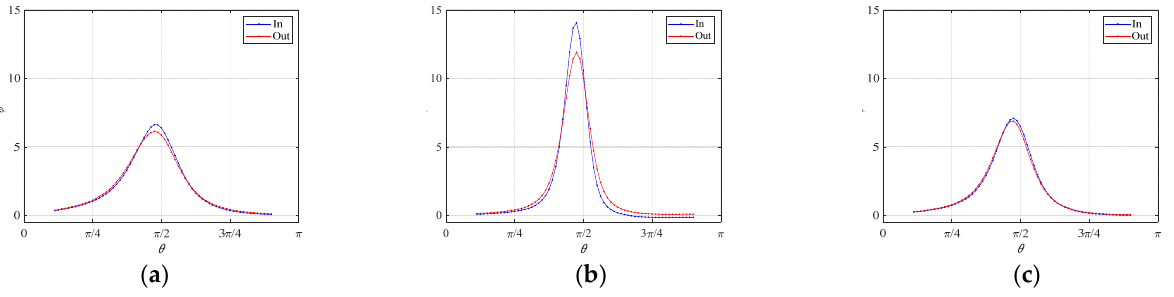
Figure 10. Azimuthal vorticity at bubble surface: ( a – c ) are under same conditions as in Figure 8.